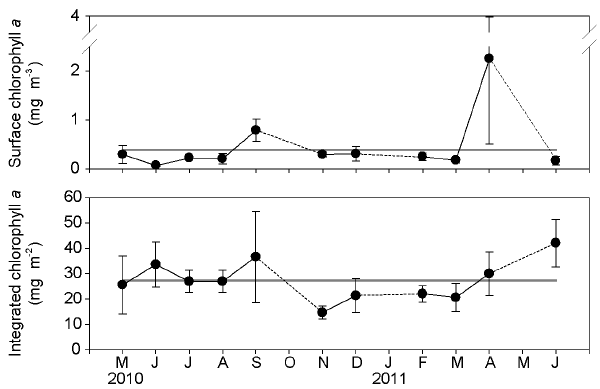
Fig. 6. Annual variations of surface and integrated chlorophyll a concentration in the Ulleung Basin during our study period. The grey line represents an average of integrated chlorophyll a concentration.